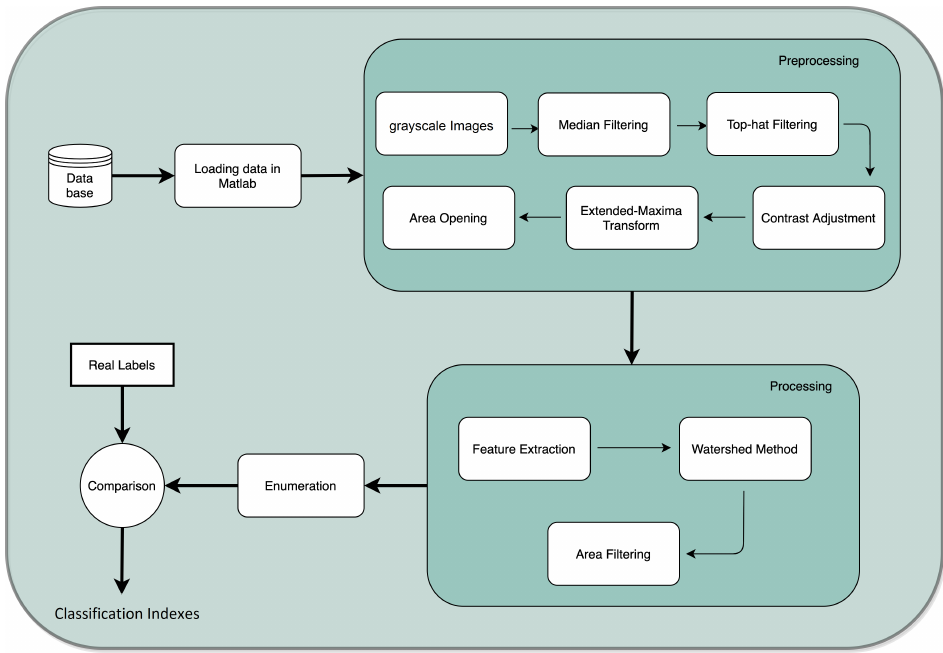
Figure 3. Flowchart of the semi-automatic enumeration process.